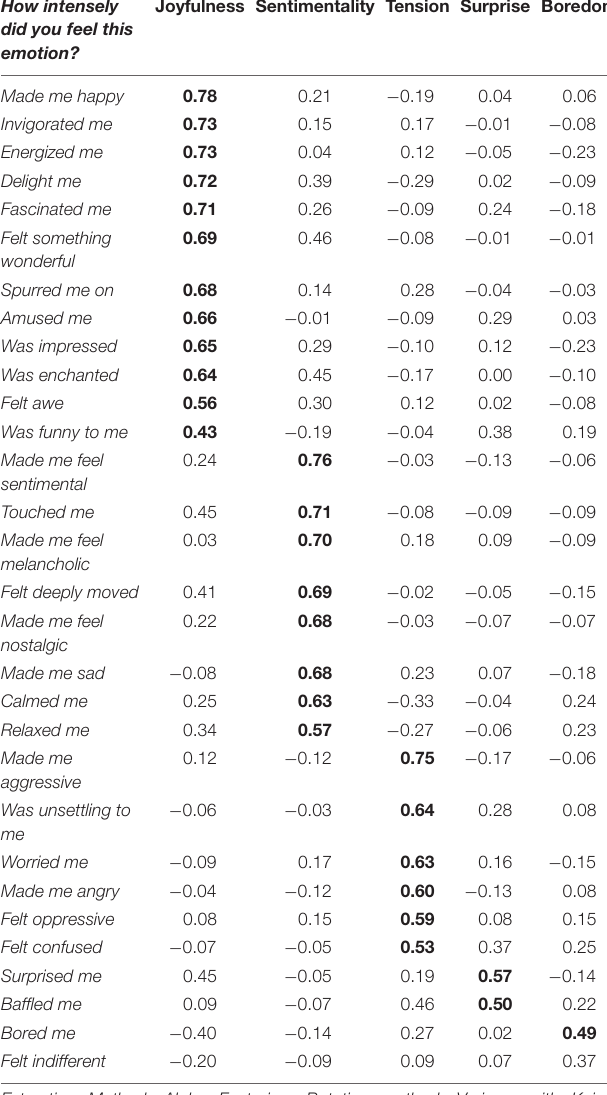
TABLE 7 | Factor loadings for exploratory factor analysis with varimax rotation of subjective feeling items (AESTHEMOS) from Concert